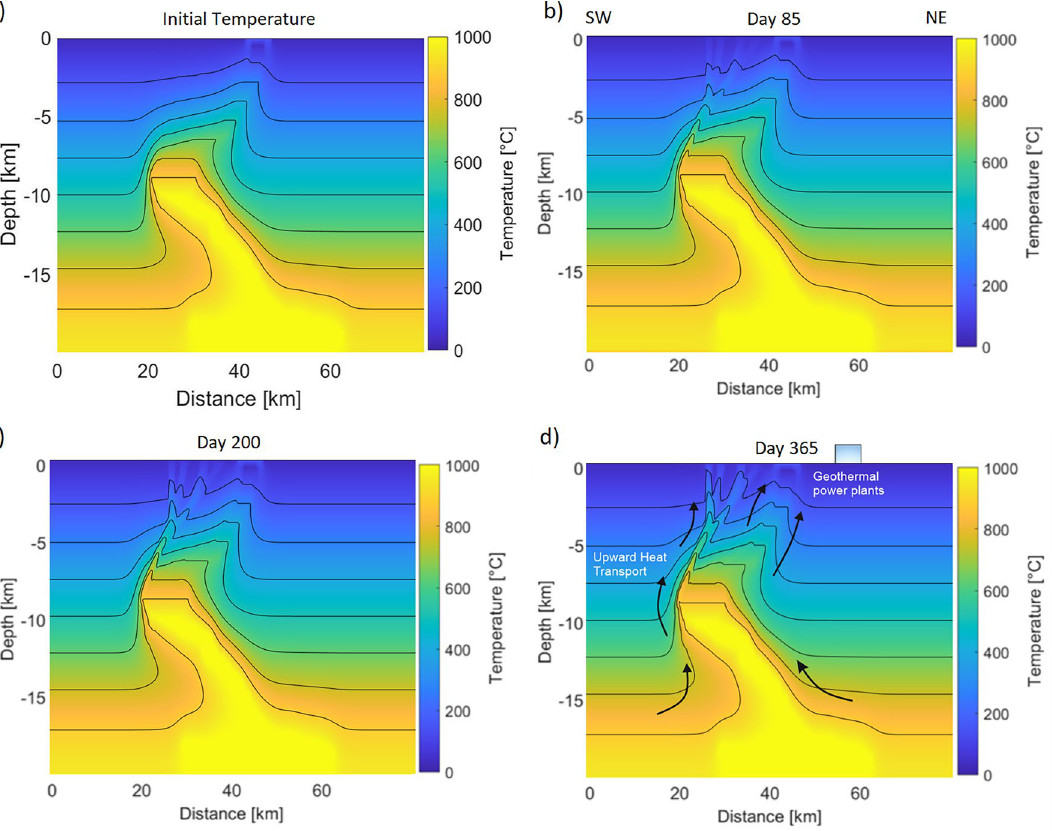
Figure 5. Advection–diffusion of temperature for different time steps. ( a ) Initial temperature distribution. ( b,c ) The heat migrate from the magma chamber to the faults and upwards within the conduit. ( d ) Temperature distribution at day 365 and location of geothermal power plants illustrating the upward migration of the heat. The entire temperature evolution is attached as a Videos 1, 2 in the